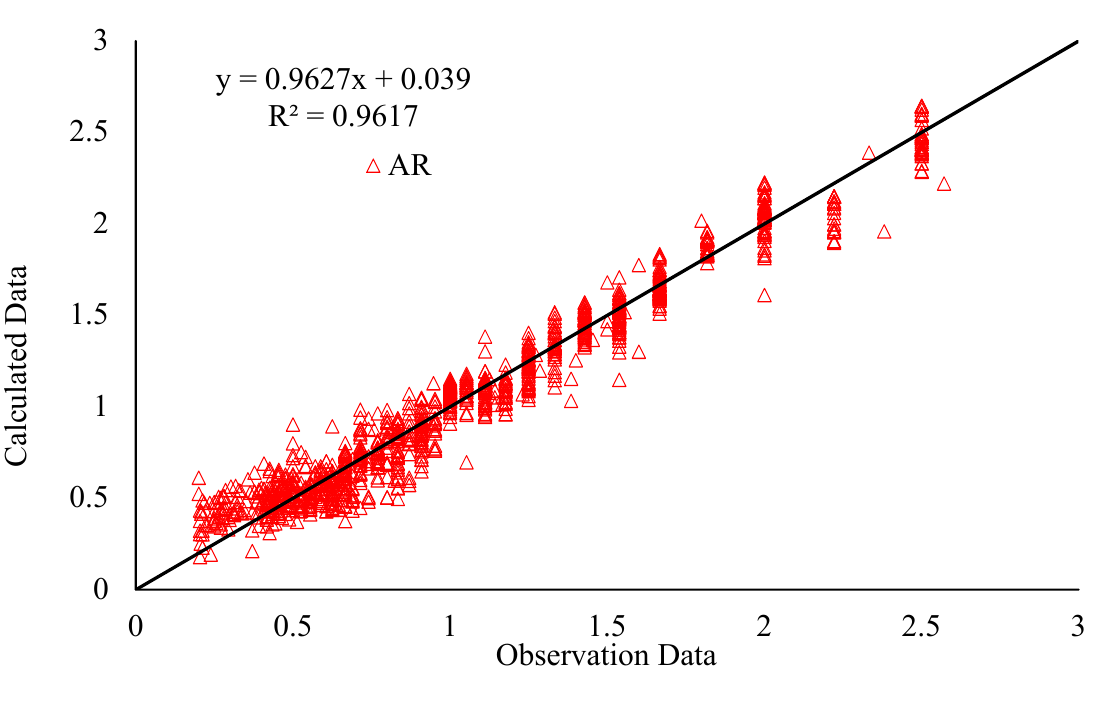
Figure 13. Predicted vs. experimental values of AR output for the PCA-ABC-ANN model using all data.